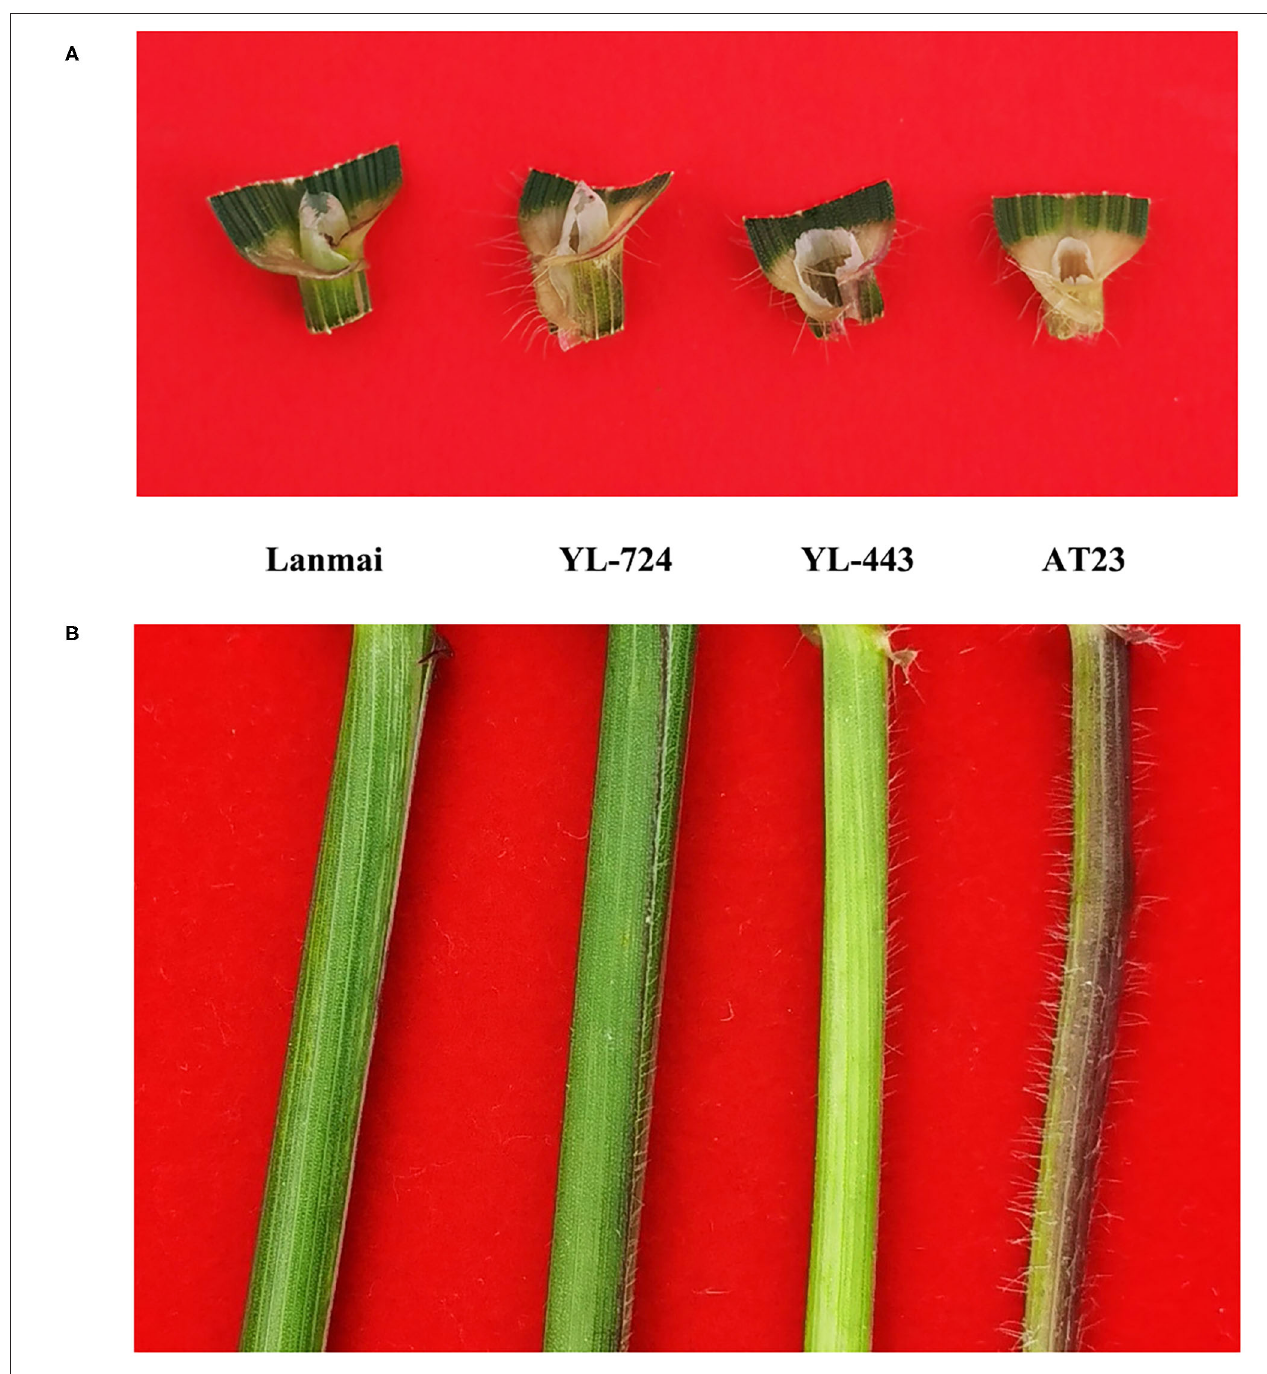
FIGURE 5 | Comparison of leaf sheath and auricles hairiness among durum wheat Lanmai, Lanmai/AT23 amphiploid line YL-724, 4D(4B) disomic substitution line YL-443, and Ae. tauschii AT23. (A) Hairy auricles comparison. (B) Hairy leaf sheath comparison.